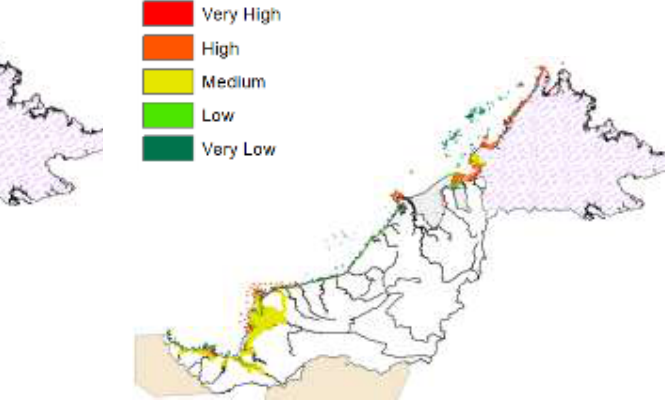
Figure 4: ESR map based on expert 1’s scaling